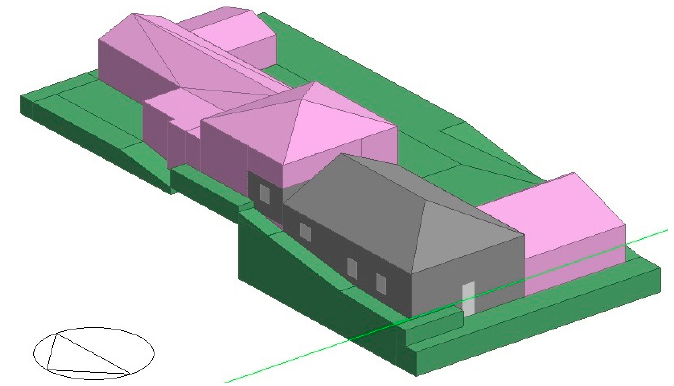
Figure 2. Design Builder Model of the wine cellar (gray).